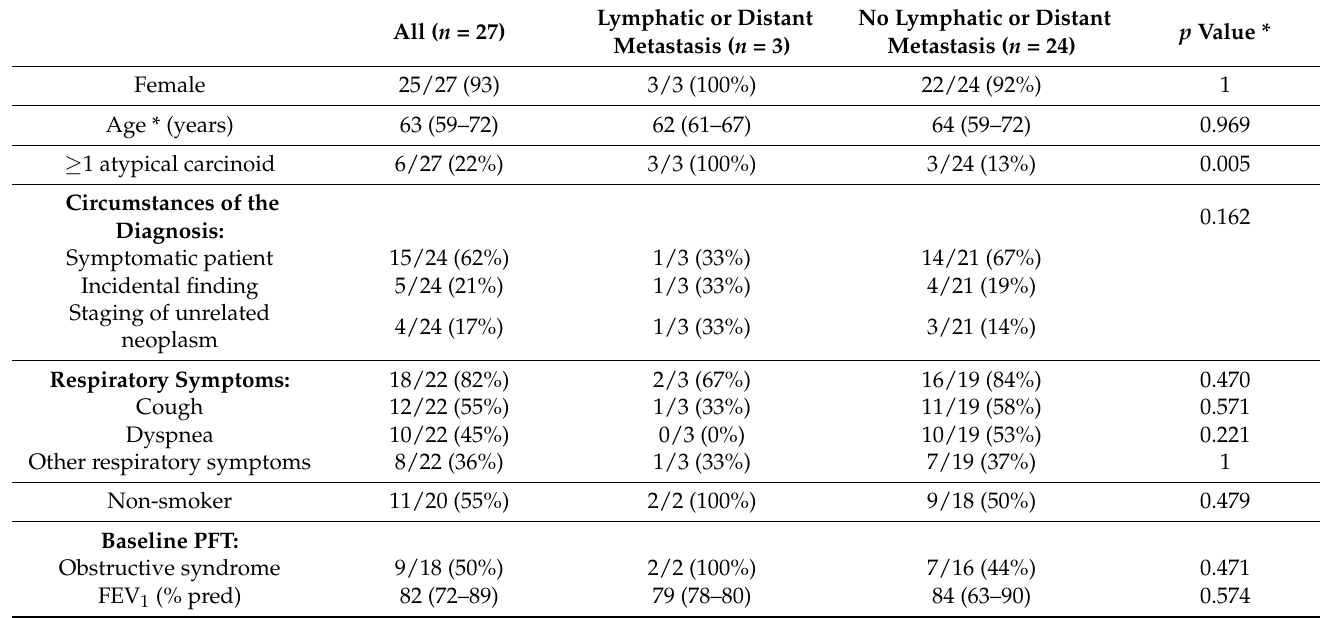
Figure 1. Flow chart. Table 1. Patient